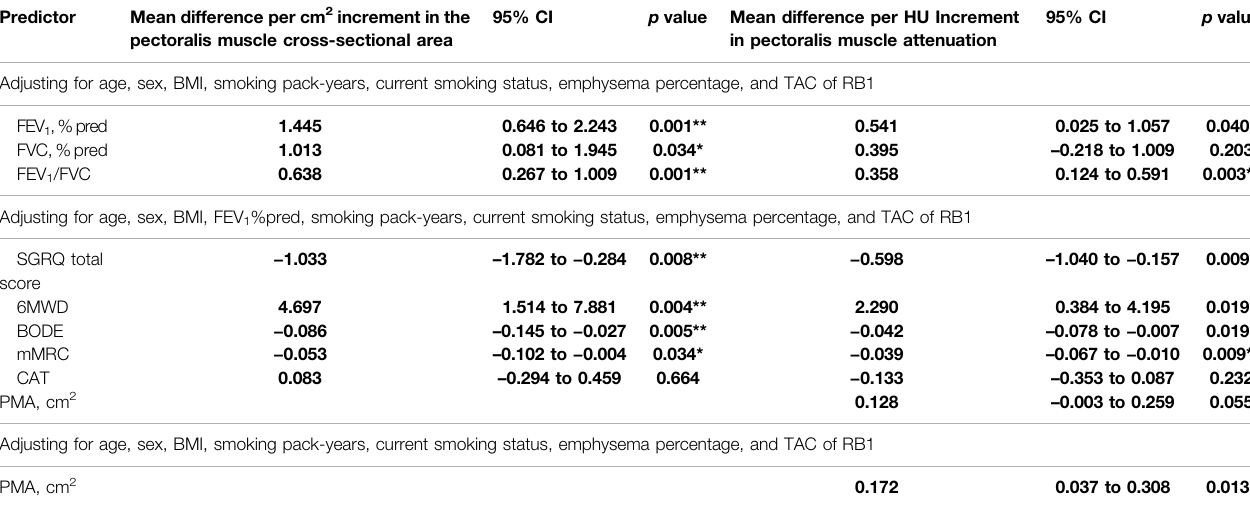
Frontiers in Physiology |